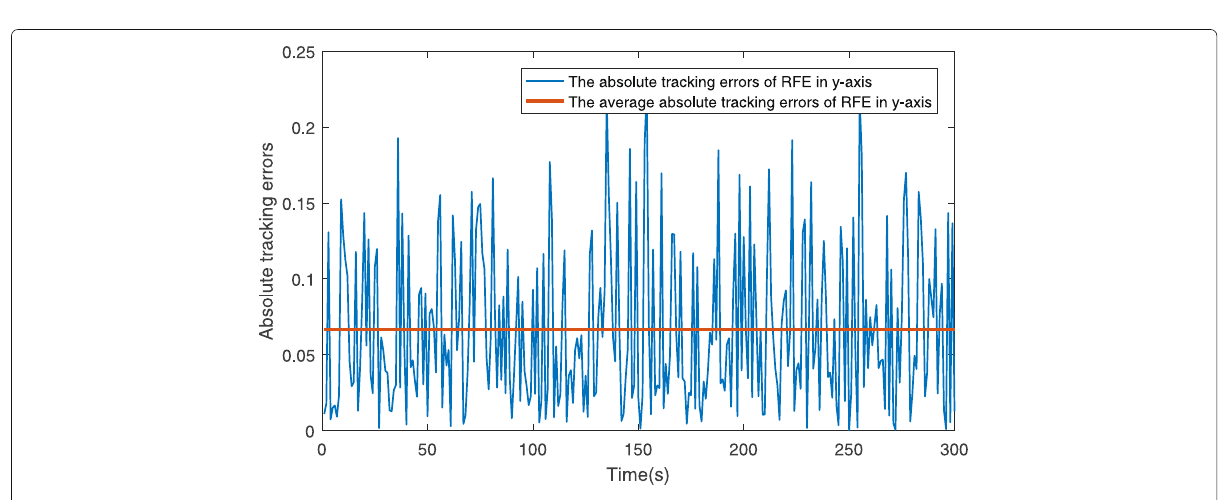
Fig. 9 The absolute tracking errors of RFE in y -axis with a i =